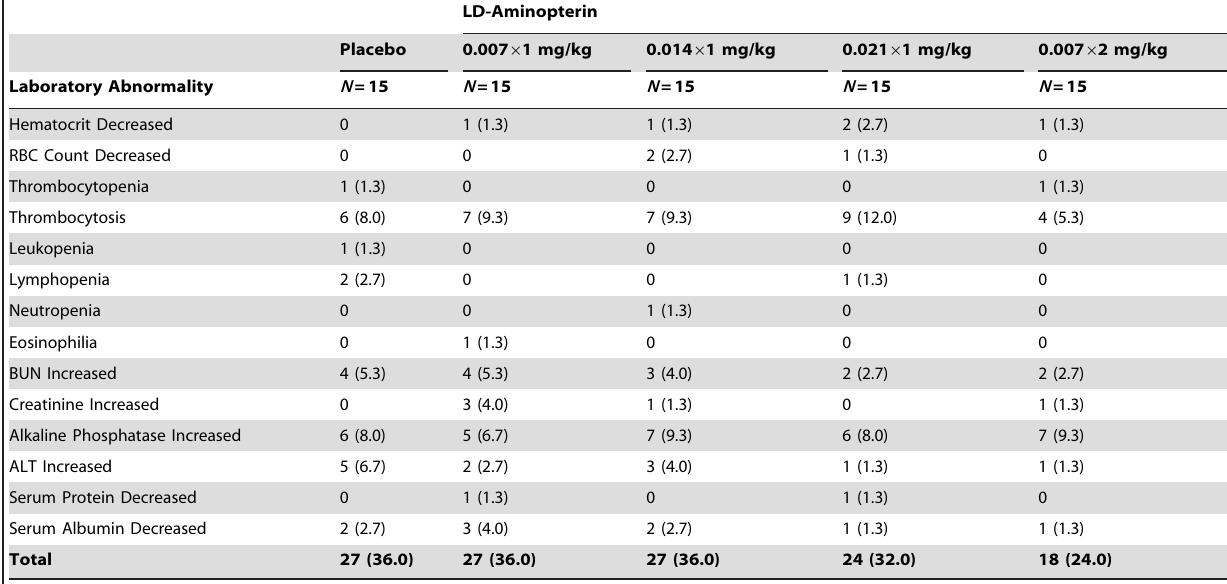
Table 4. Summary of laboratory AEs by cohort a